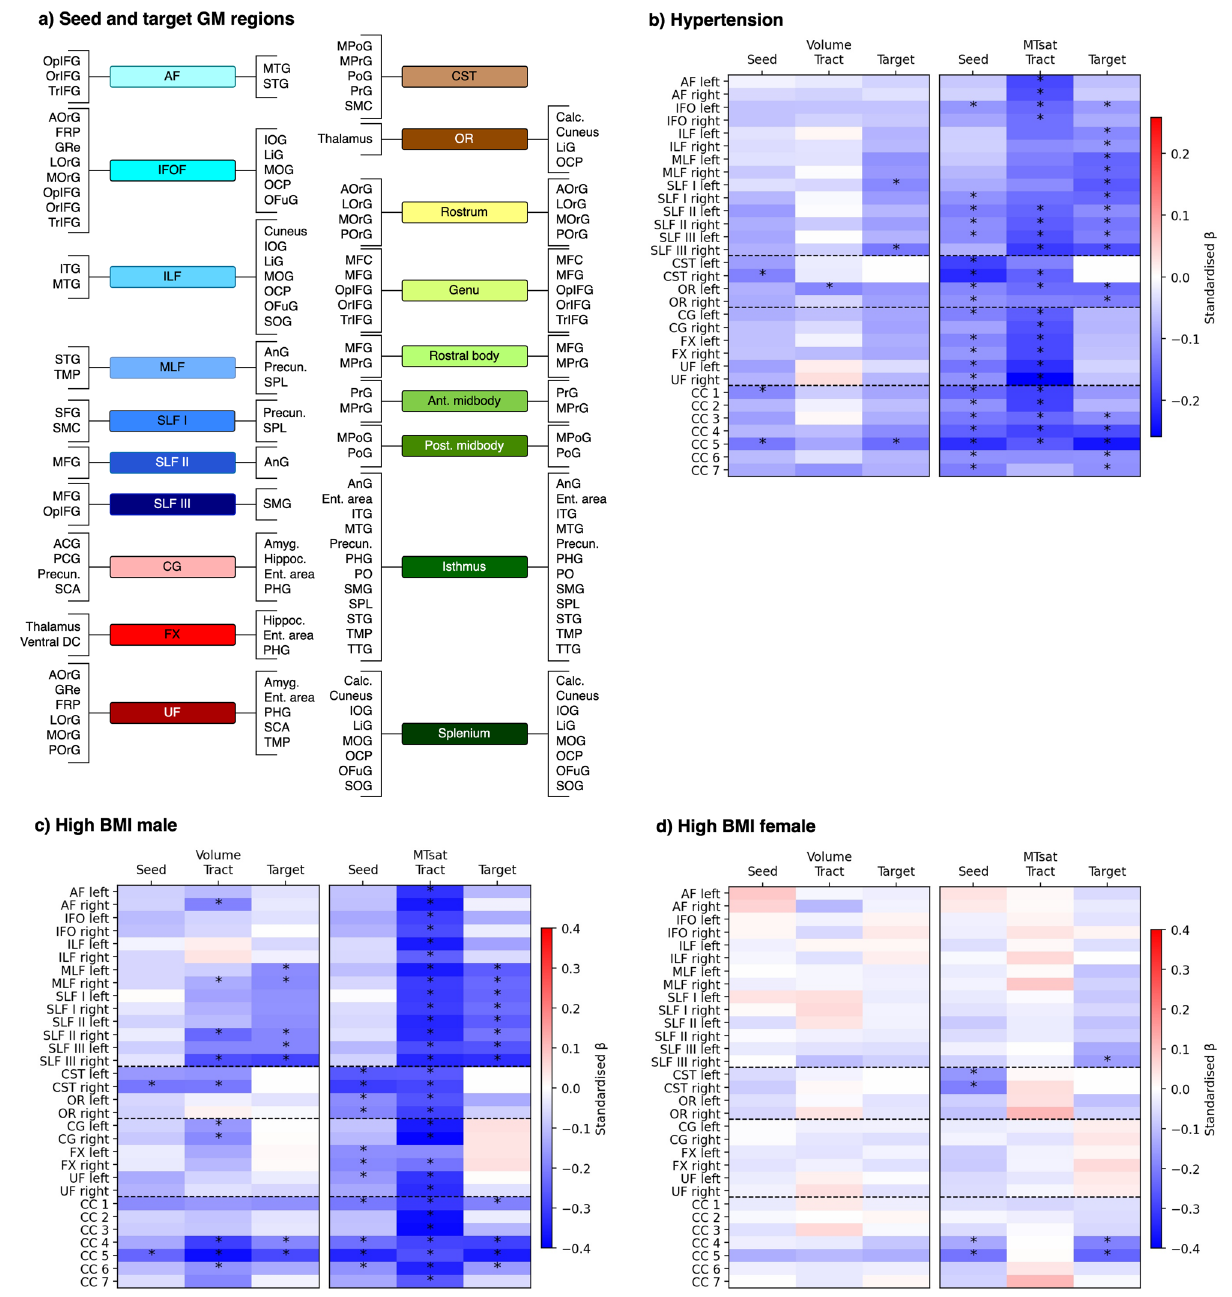
Fig. 6 CVRF associations with volume and MTsat in white matter tracts and their grey matter seed and target regions ( n = 1104). Standardised β s are marked with an asterisk for signi fi cant associations (FDR-corrected p < 0.05). a Constituent sub-regions of the seed and target of each tract. b GM and WM associations with hypertension. c , d GM and WM associations with high BMI in c male and d female participants. A/PCG anterior/posterior cingulate gyrus, AF arcuate fasciculus, Amyg amygdala, AnG angular gyrus, A/L/M/POrG anterior/lateral/middle/posterior orbital gyrus, BMI body mass index, Calc calcarine cortex, CC corpus callosum (1 = rostrum, 2 = genu, 3 = rostral body, 4 = anterior midbody, 5 = posterior midbody, 6 = isthmus, 7 = splenium), CG cingulum bundle, CST cortico-spinal tract, Ent. area entorhinal area, FRP frontal pole, FX fornix, GM grey matter, GRe gyrus rectus, Hippoc hippocampus, IFO inferior fronto-occipital fasciculus, ILF inferior longitudinal fasciculus, I/M/SOG inferior/middle/superior occipital gyrus, I/M/S/ TTG inferior/middle/superior/transverse temporal gyrus, LiG lingual gyrus, MFC medial frontal cortex, M/SFG middle/superior frontal gyrus, MLF middle longitudinal fasciculus, (M)Po/PrG post/precentral gyrus (medial segment), MTsat magnetization transfer saturation, Op/Or/TrIFG opercular/orbital/ triangular part of inferior frontal gyrus, OCP occipital pole, OFuG occipital fusiform gyrus, OR optic radiation, PHG parahippocampal gyrus, PO parietal operculum, Precun precuneus, SCA subcallosal area, SLF superior longitudinal fasciculus, SMC supplementary motor cortex, SMG supramarginal gyrus, SPL superior parietal lobule, TMP temporal pole, UF uncinate fasciculus, Ventral DC ventral diencephalon, WM white